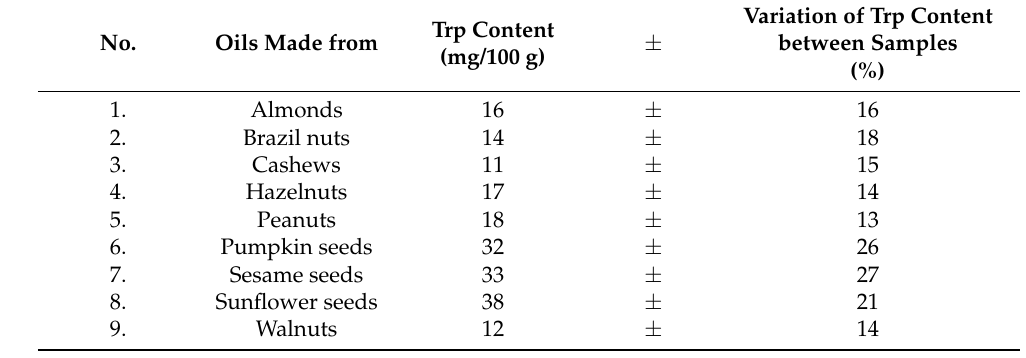
Table 4. Trp (free) content in vegetable oils.